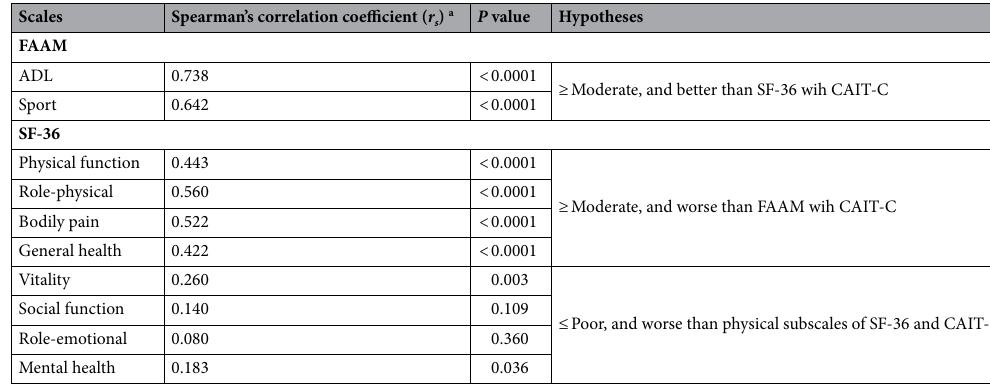
Table 4. Construct validity of the CAIT-C. CAIT-C Chinese version of Cumberland Ankle Instability Tool, FAAM foot and ankle ability measure, ADL activity of daily living, SF-36 Short-Form 36. a Calculated by the Spearman’s correlation coefficient ( r s ) of the CAIT-C with FAAM and